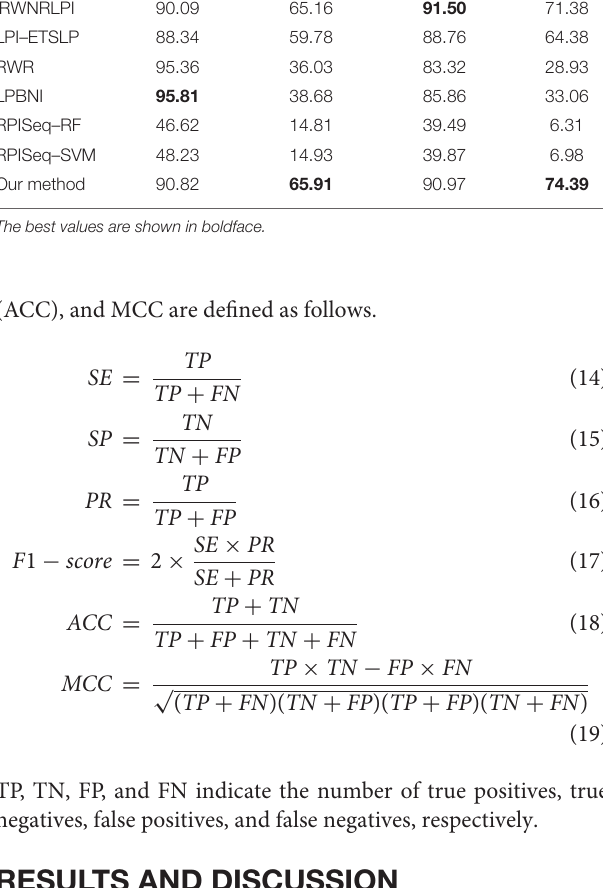
TABLE 3 | Comparison of performance with different excellent algorithms. Methods